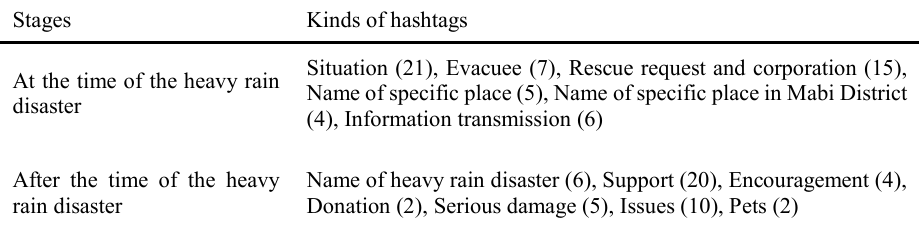
Table 1. Kinds of hashtags related the Heavy Rain Disaster in Western Japan in